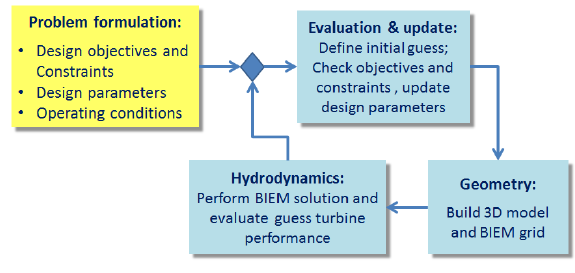
Fig. 1. Problem formulation and main modules of the computational design